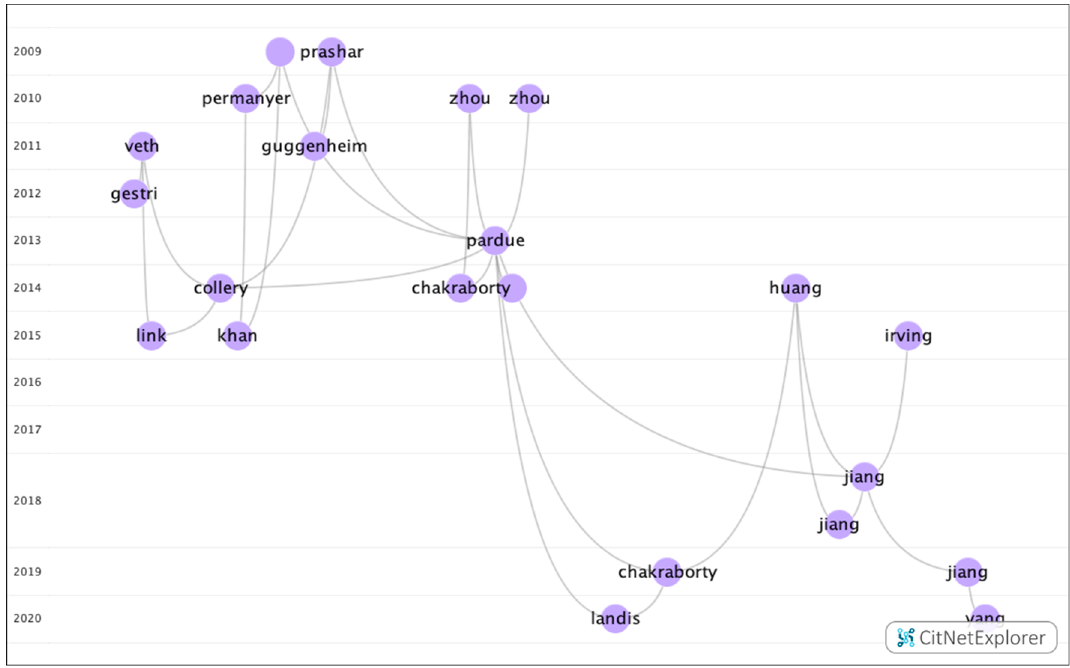
Figure 10. Citation network in group 3 .